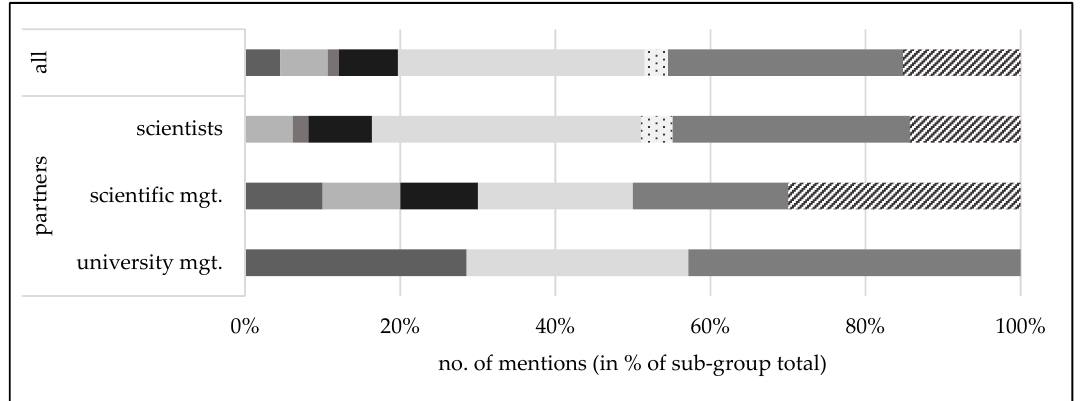
Figure 3. Use of power tactics by science managers by relationship partner.